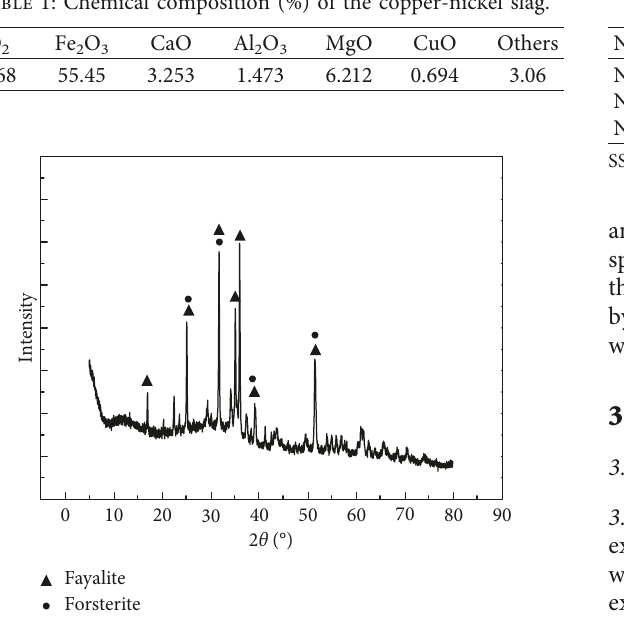
Figure 2: XRD patterns of the copper-nickel slag.